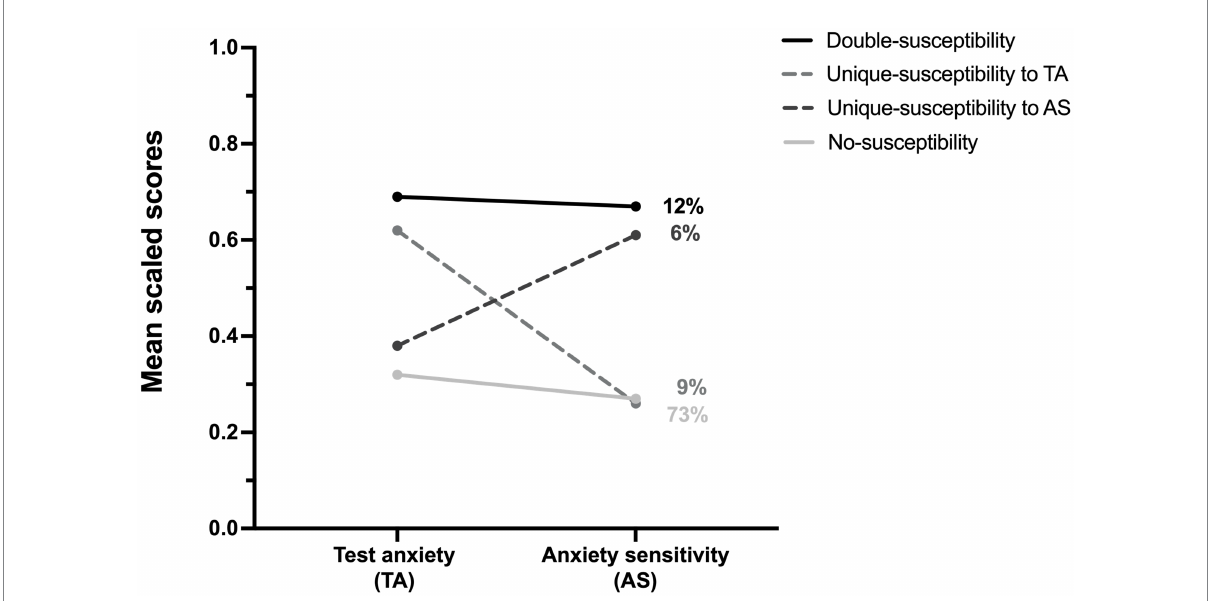
FIGURE 2 Mean scaled scores of test anxiety and anxiety sensitivity by latent